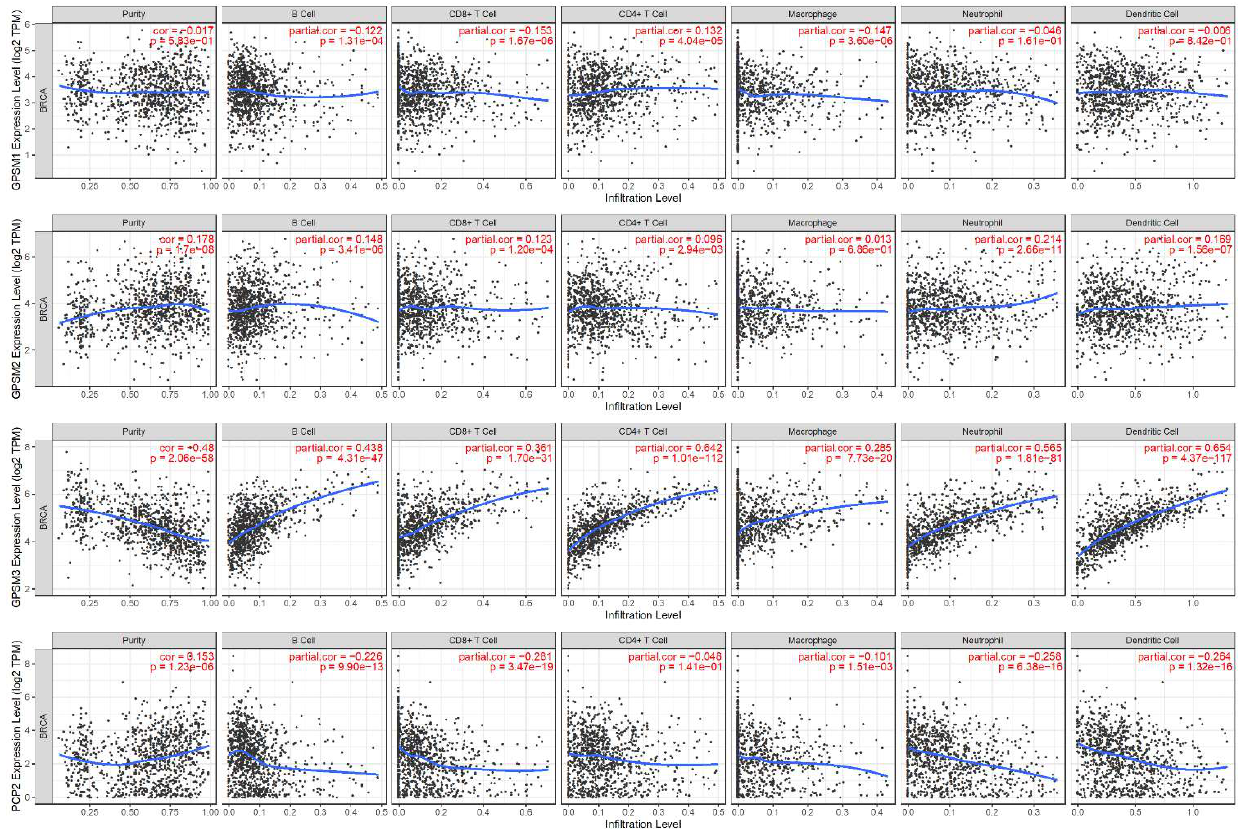
Figure 9. Relationships between GPSMs expression and immune infiltration level in breast cancer (TIMER). Horizontal axis, expression levels of GPSMs (values represented as log2 RSEM); vertical axis, tumor infiltrating immune cell markers (purity, B cell, CD8+ T cell, CD4+ T cell, macrophage, neutrophil, dendritic cell) TPM, transcript count per million; cor, correlation coefficient.